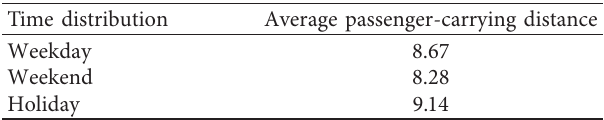
Table 9: Average carrying passenger distance of taxis in Shanghai in different periods (km).